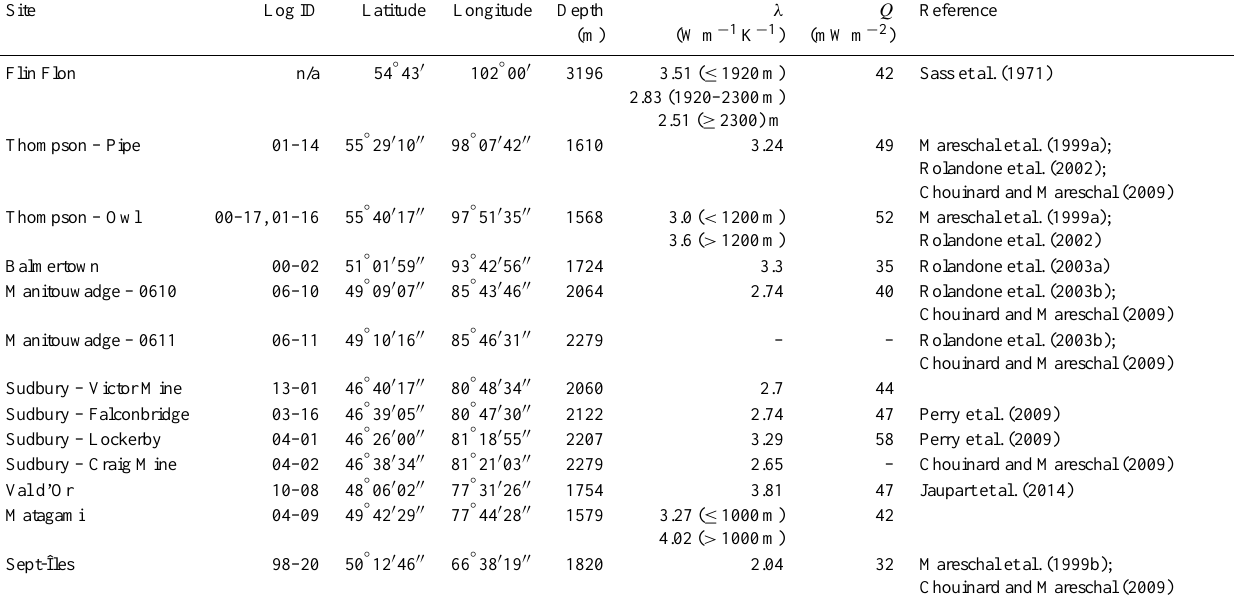
Table 1. Technical information concerning the boreholes used in this study. Site Log